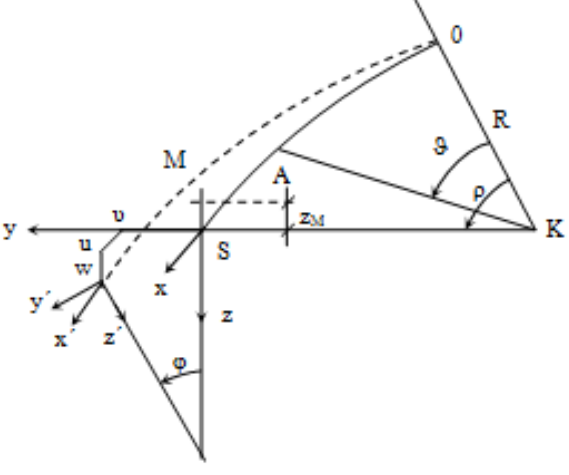
Figure 1: Geometrical notations and displacements for a curved bridge